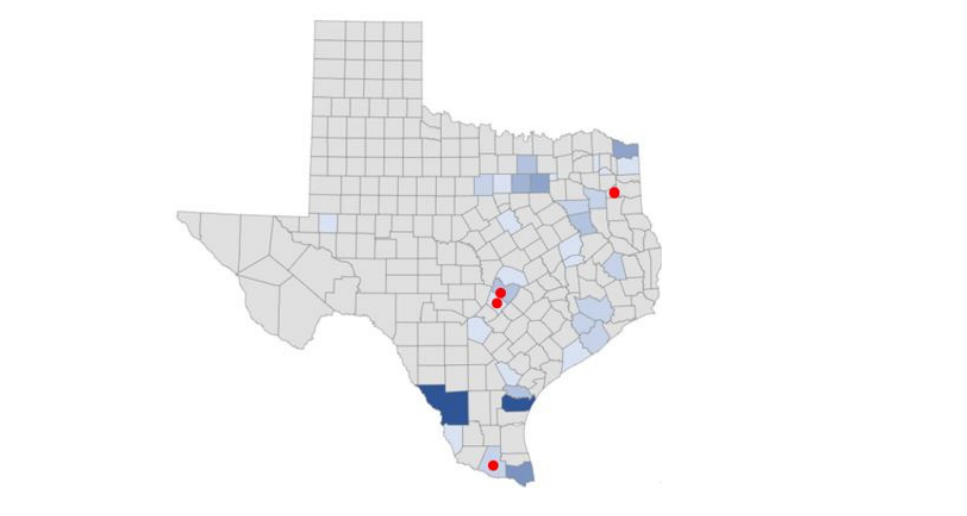
Figure 8. Map of DSHS locally acquired and unknown ehrlichiosis, chaffeensis, 2008–2020, by respondents with most severe symptoms.